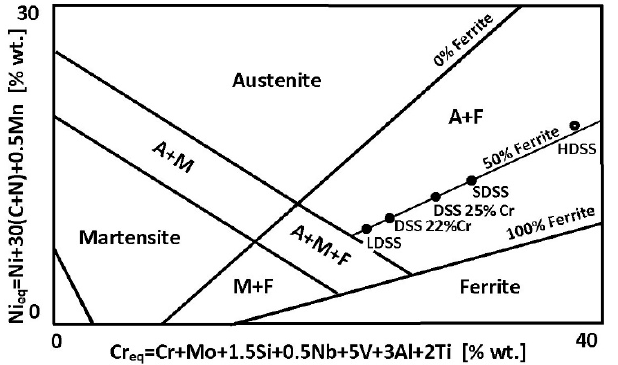
Figure 4. Location of individual categories of duplex steels in the Schaeffler–DeLong diagram— according to [21].